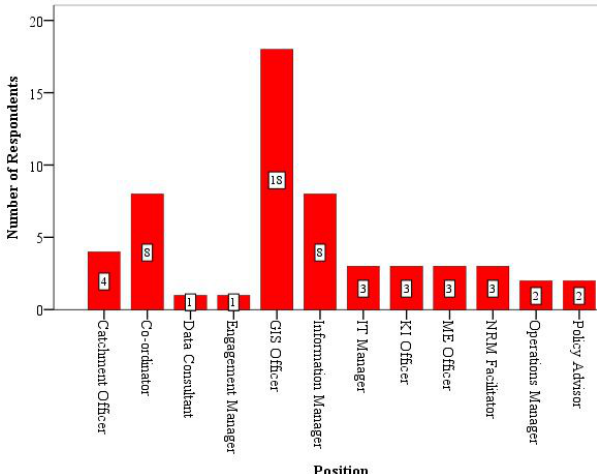
Figure 3. Profile of respondents (by position)